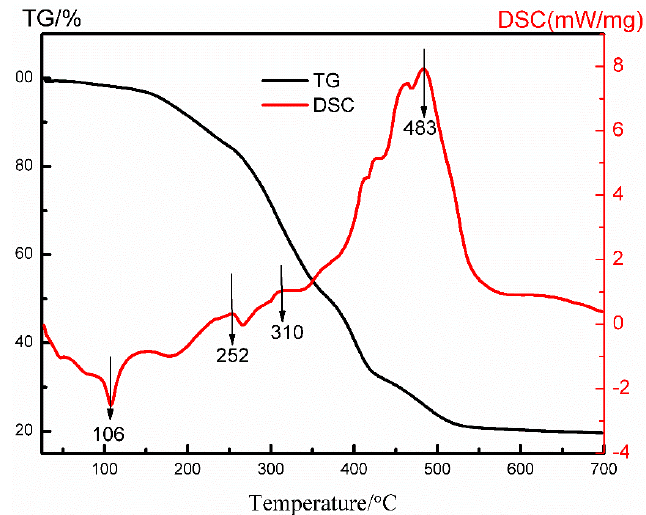
Figure 2. TG–DSC curve of the ZnO xerogel.